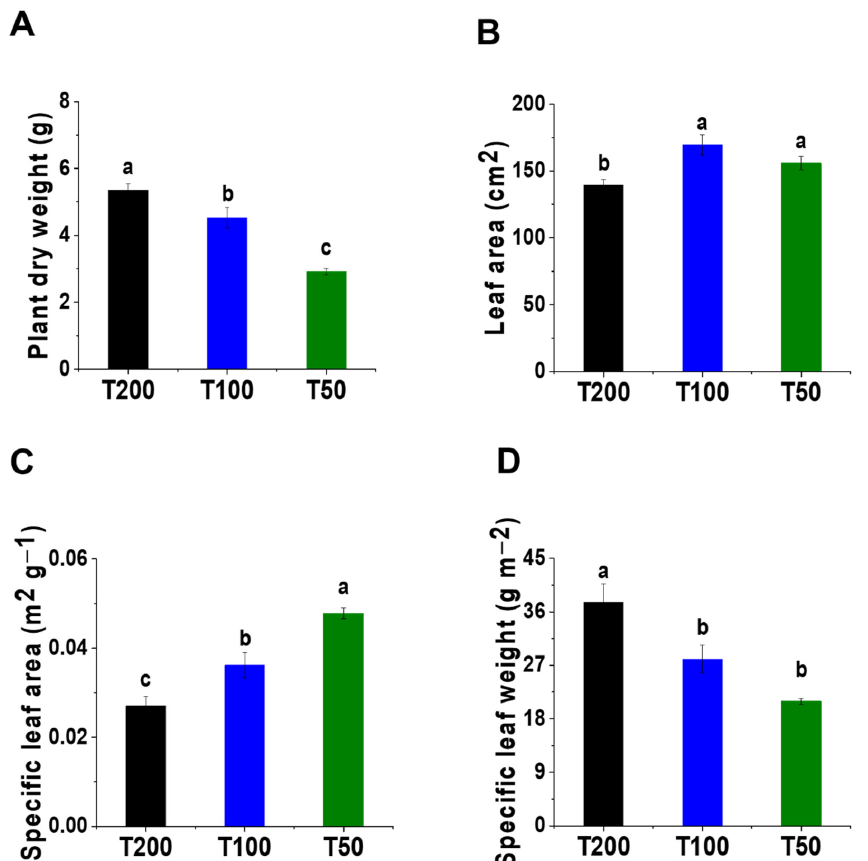
Figure 2. Effect of different light intensities on plant dry weight ( A ), leaf area ( B ), specific leaf area ( C ), and specific leaf weight ( D ). The error bars on the mean values are ± SE (standard error). A column with different letters denotes significant differences using the LSD test at p < 0.05. T200 stands for the seedlings under a light intensity of 200 μ mol m − 2 s − 1 ; T100 stands for the seedlings under a light intensity of 100 μ mol m − 2 s − 1 ; and T50 stands for the seedlings under a light intensity of 50 μ mol m − 2 s − 1 .